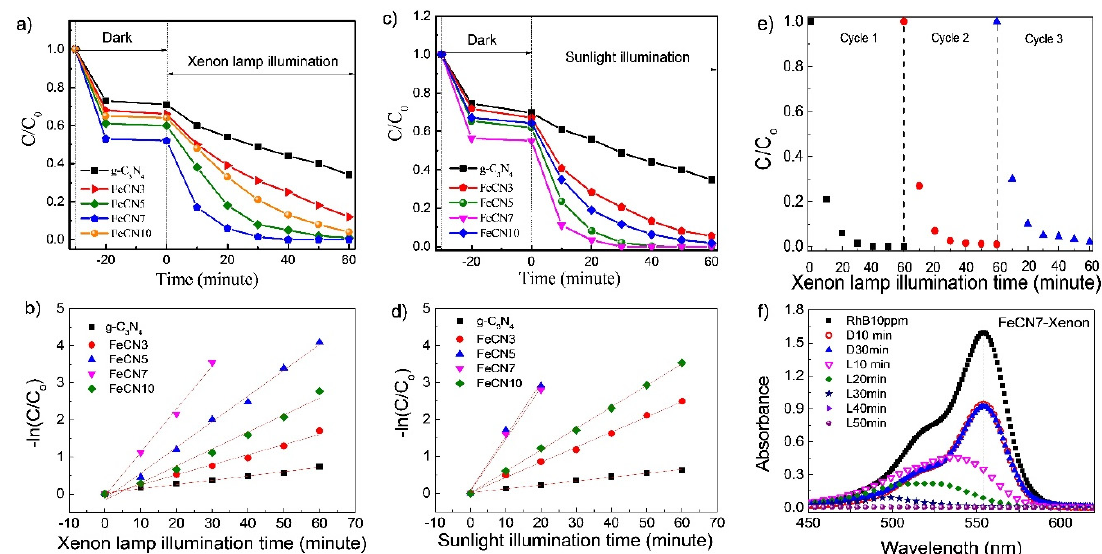
Figure 9. Photocatalytic activities and reaction rate of Fe-doped g-C 3 N 4 nanosheets with different Fe concentrations in decomposing RhB solution under ( a , b ) Xenon lamp illumination and ( c , d ) sunlight illumination; ( e ) the reusability of as-prepared Fe-doped g-C 3 N 4 photocatalyst and ( f ) the change of absorption maxima and absorption intensity of RhB solution at different times.